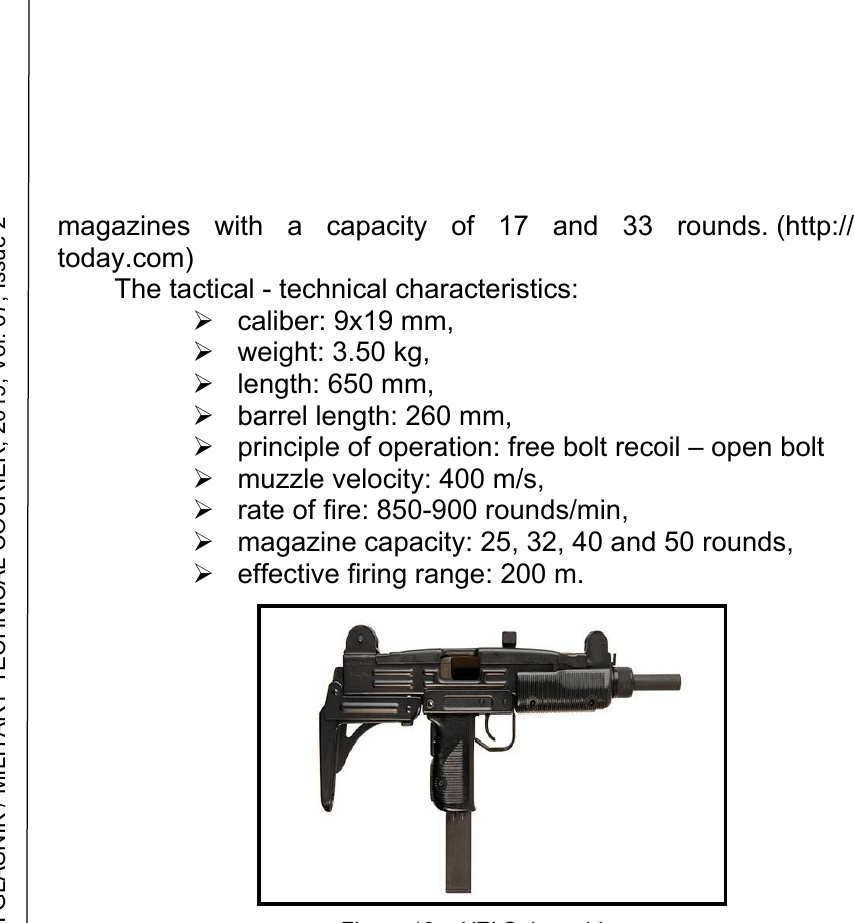
Figure 13 – UZI Submachine gun Рис . 13 – Автомат UZI Слика 13 – Аутомат